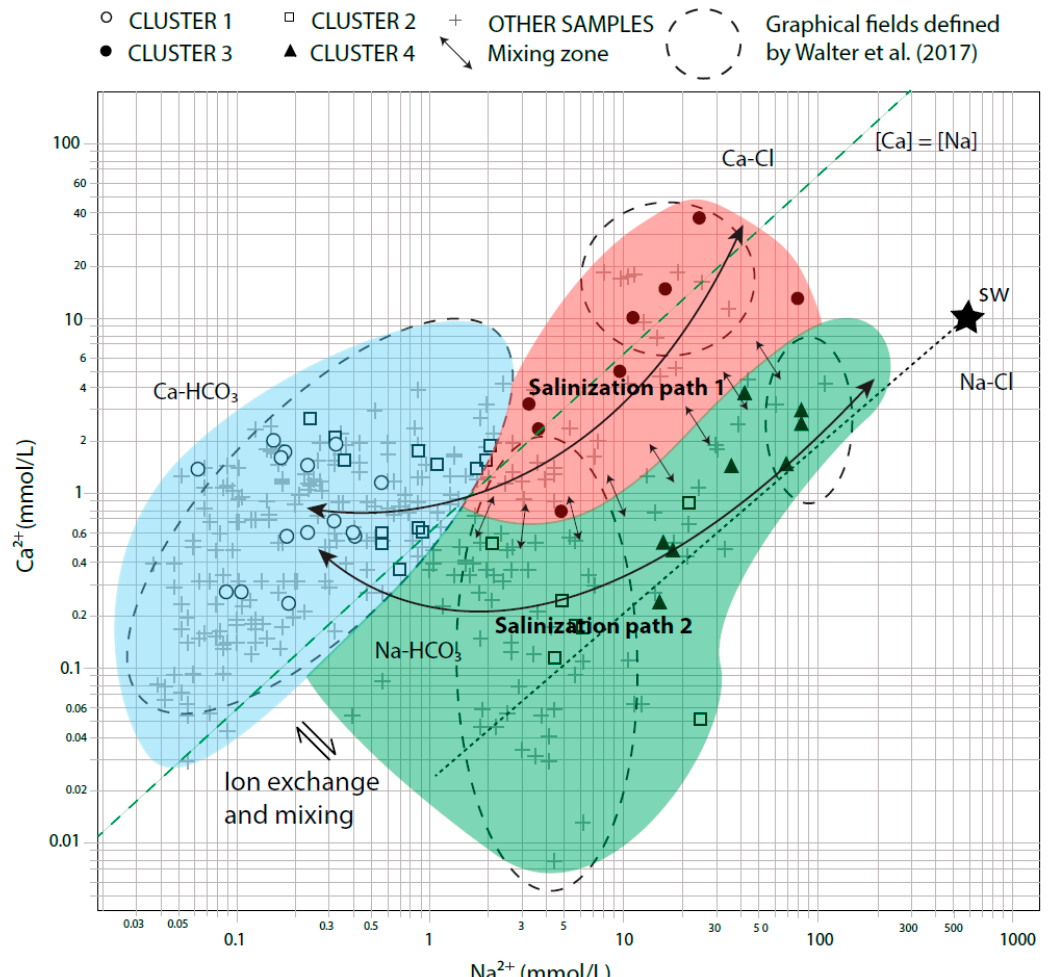
Figure 9. Log-log plot of calcium versus sodium. Samples that were not included in the subset of data are marked with the symbol (+).